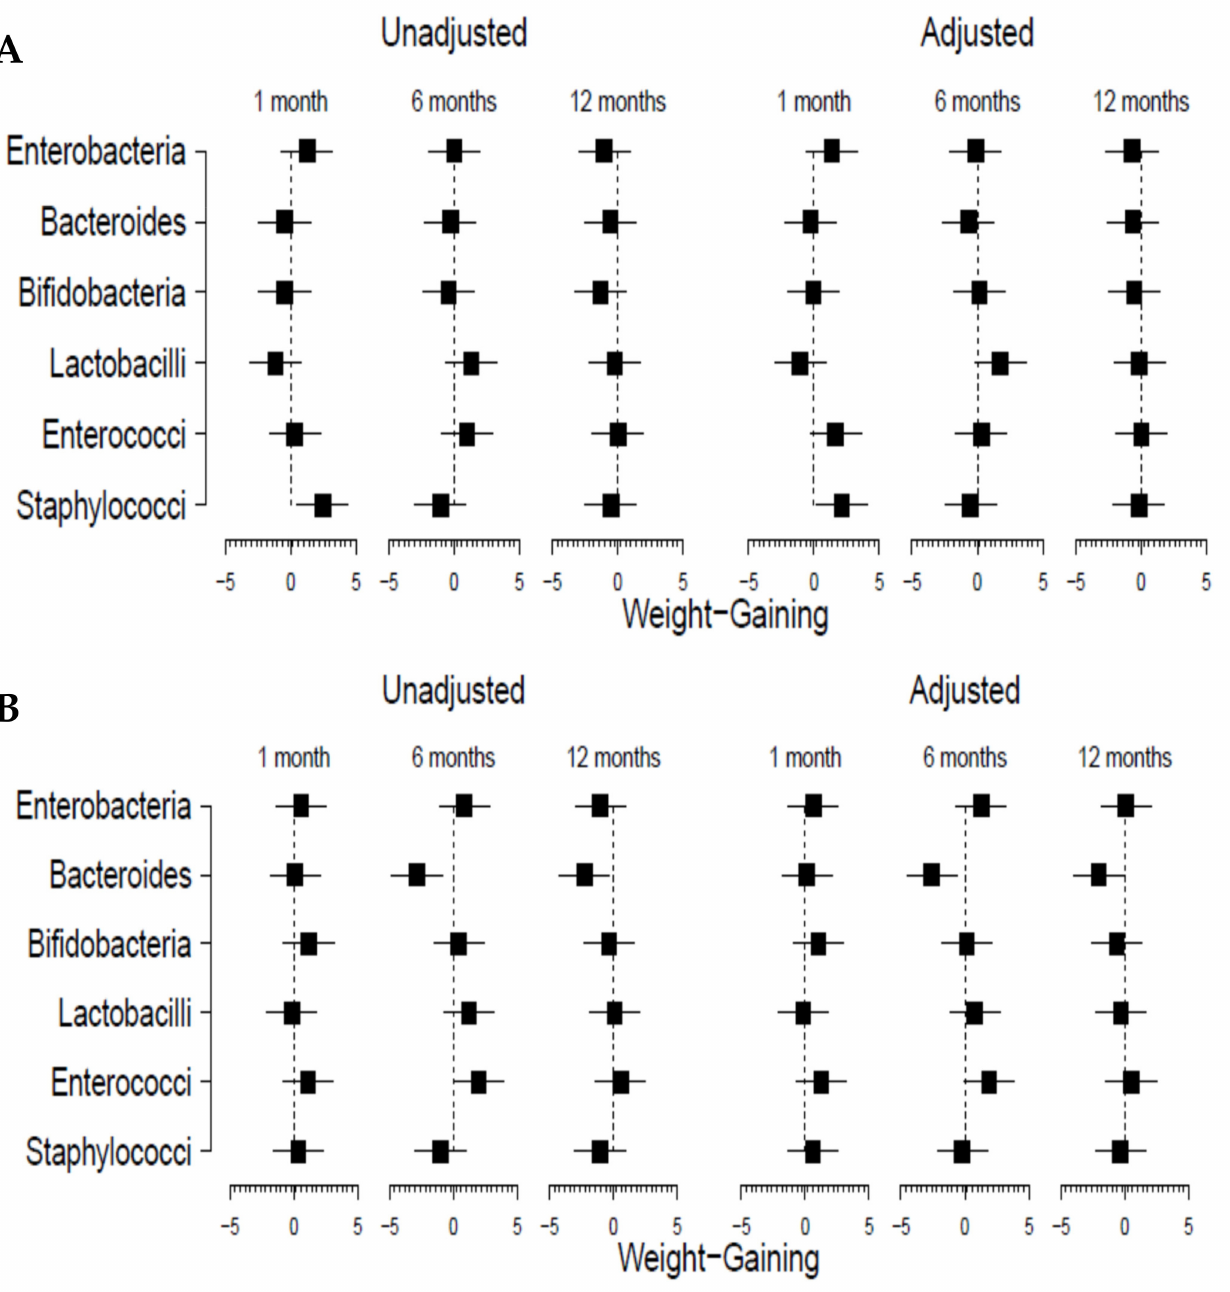
Figure 3. Forrest plots showing the effect sizes (with 95% confidence interval) of the association of microbiota-related variables with infant weight gain at 1, 6 and 12 months of age according to delivery mode (vaginal delivery ( A ) and C-section ( B )). Results from unadjusted model and adjusted by gender and type of feeding. Dotted lines represent the zero value, with values on the left side indicating negative associations and those on the right side indicating associations with positive